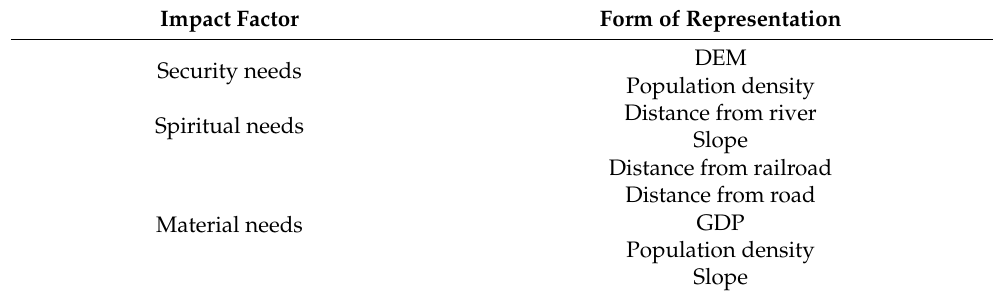
Table 4. Table of impact factor